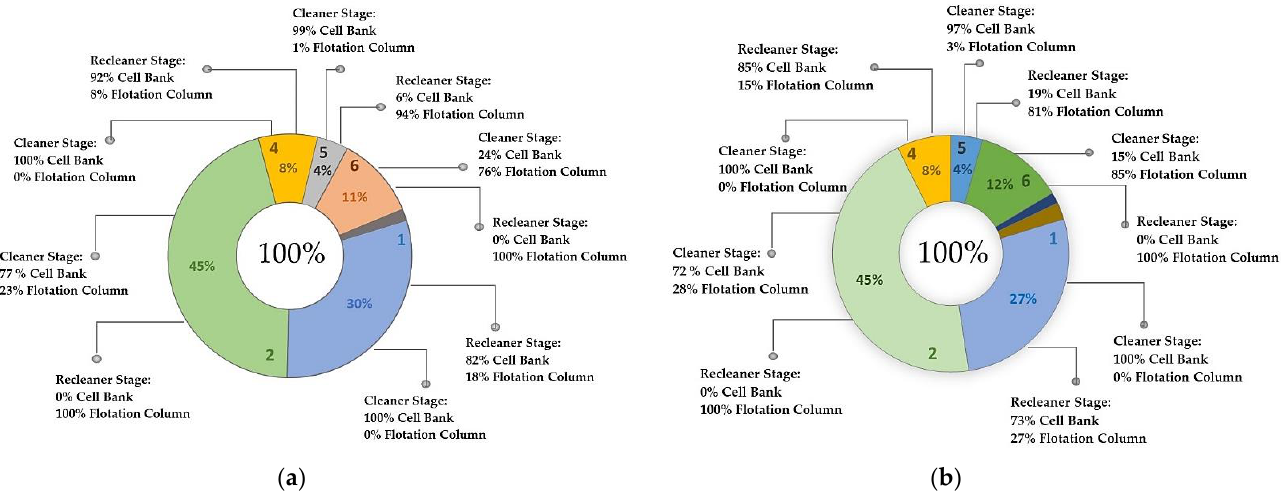
Figure 6. Graphical representation of the percentage of optimal structures ( a ) without uncertainty in the copper price, and ( b ) with a copper price uncertainty described by U[000,000,3,4] USD/t.